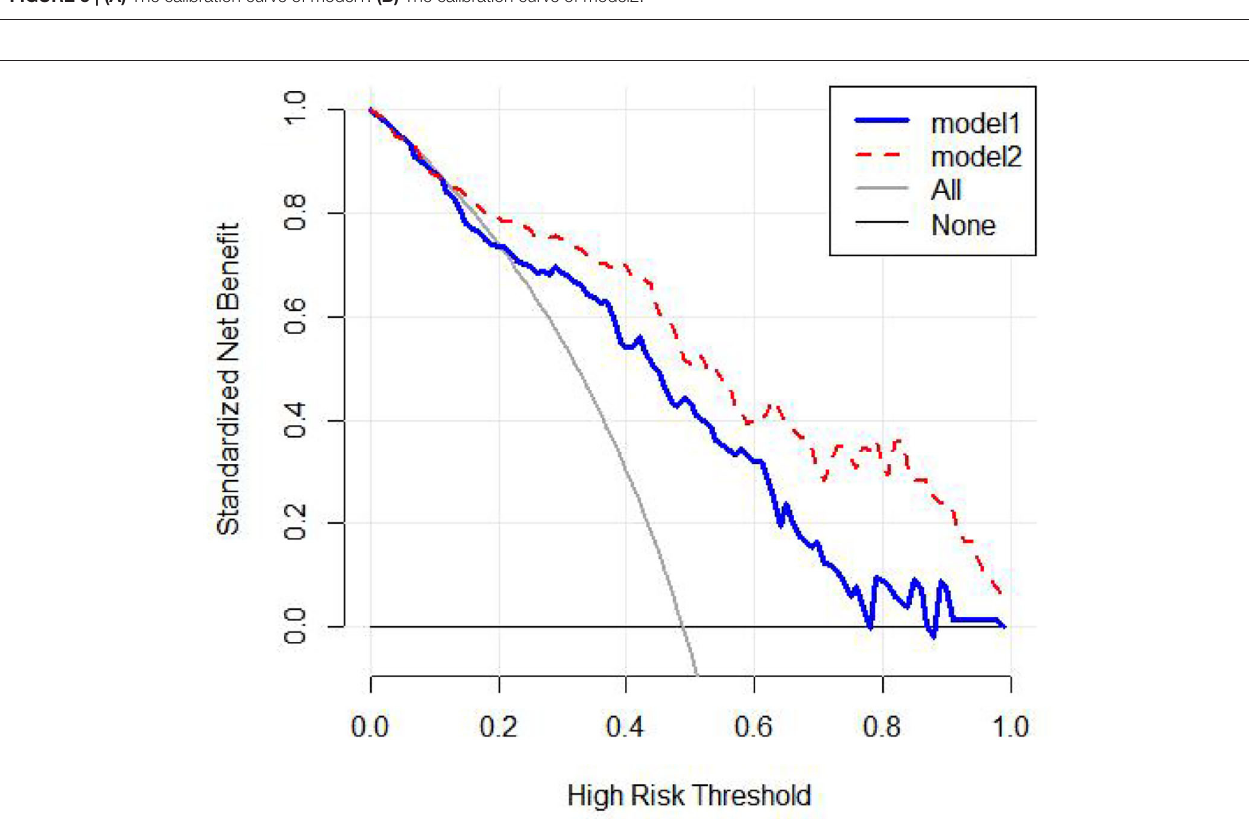
FIGURE 4 | The decision curve analysis for model1 and